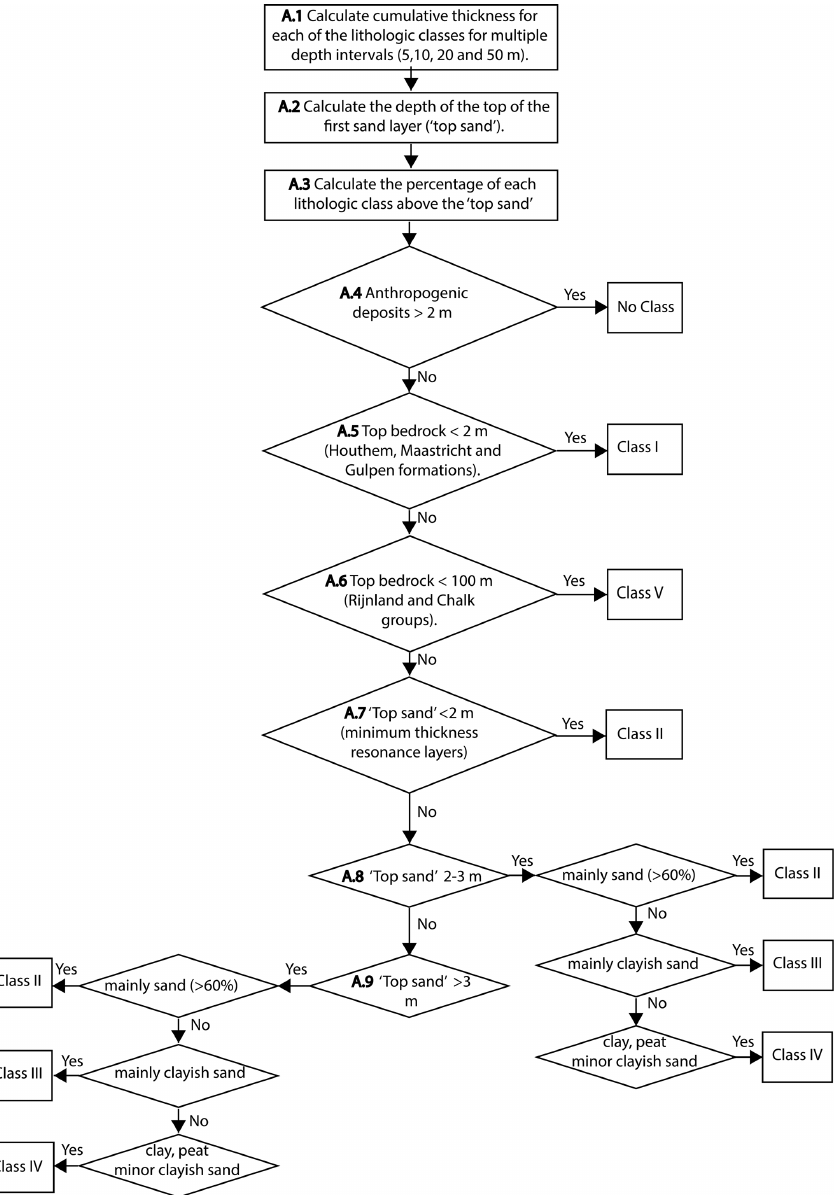
Figure 10. General outline of the vertical voxel-stack analysis used to assign the appropriate sediment class into each grid cell of the GeoTOP and NL3D geological models in the construction of the site-response zonation